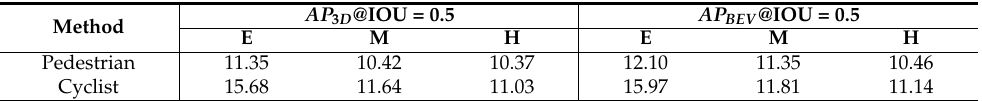
Table 4. Evaluation for multi-class detection of pedestrian and cyclist on val 1 by AP 3 D and AP BEV metrics: E, M, and H indicate the levels from Easy, Moderate, to Hard.